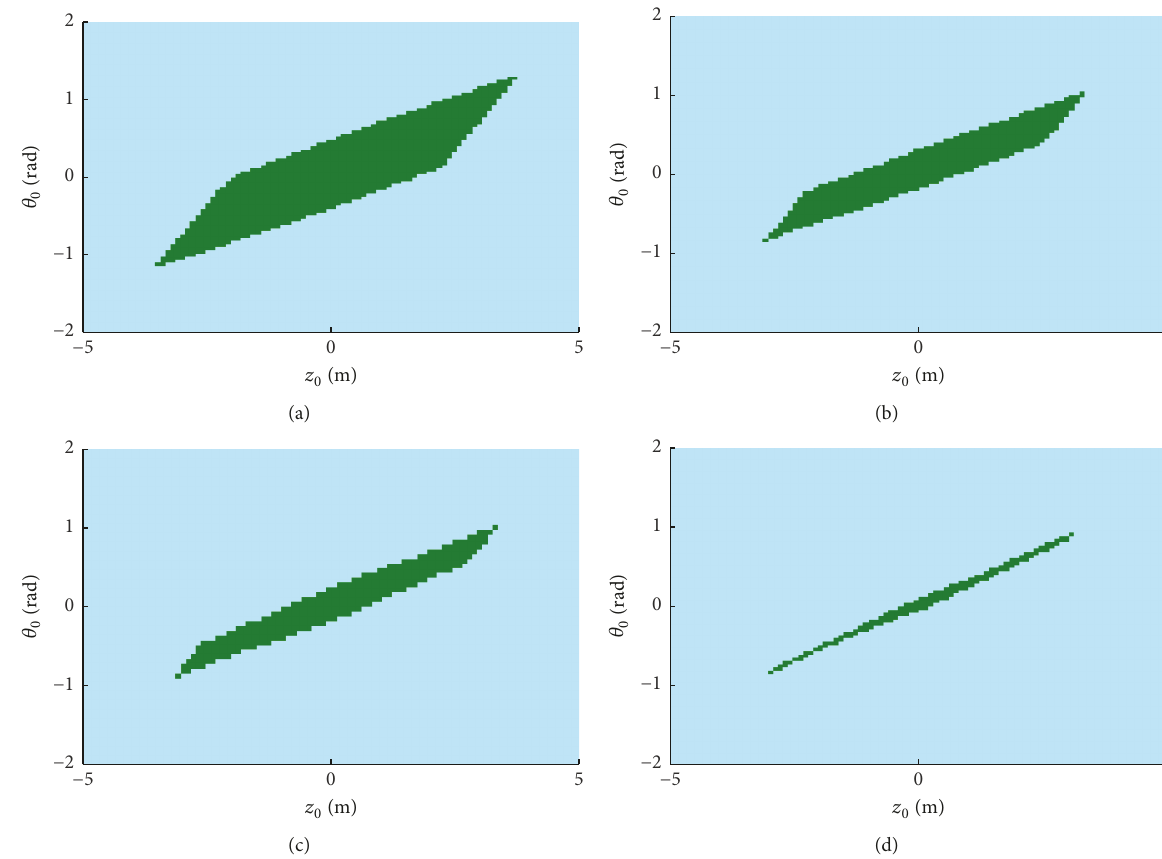
Figure 8: Basins of attraction: (a) 𝜎 = 0.02788 , 𝑘 = 8.874 ; (b) 𝜎 = 0.02838 , 𝑘 = 9.369 ; (c) 𝜎 = 0.02754 , 𝑘 = 11.06 ; (d) 𝜎 = 0.02636 , 𝑘 = 10.04